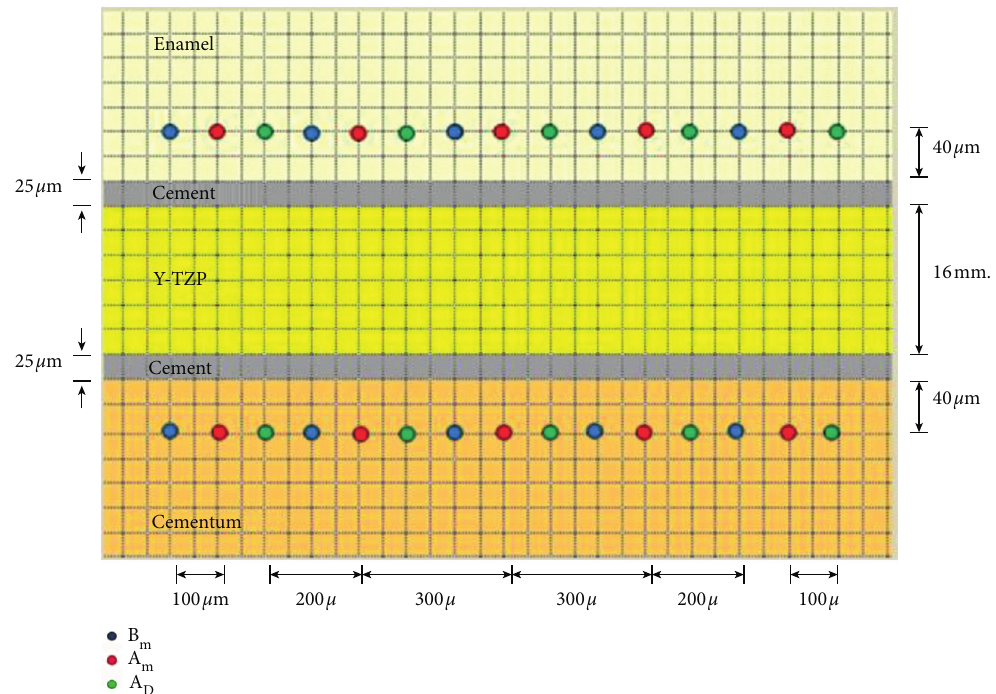
Figure 2: Vickers microhardness of enamel and cementum was determined before material application ( B ( A M ), and inducing demineralization ( A D ) (5 locations each; with 100 microns apart) at 40 microns from enamel-resin cement junction and cementum-resin cement